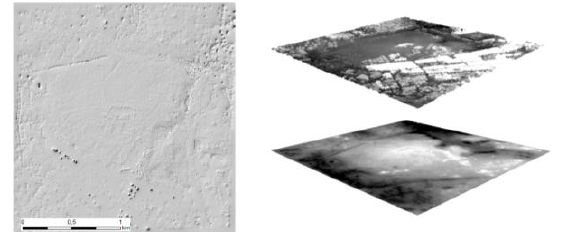
Figure 18. DEM of the Archaeological park of Centocelle (left) and DTM extraction from the DSM (right)